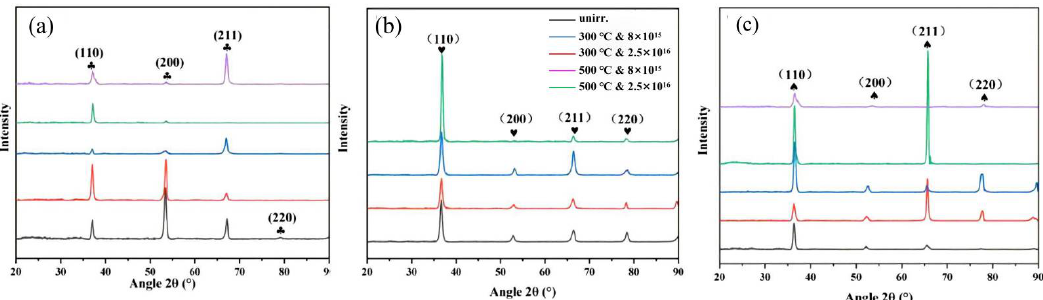
Figure 5. XRD patterns of the unirradiated and irradiated MEAs at different ion influences and tem- peratures. ( a ) Zr 40 Nb 35 Ti 25 (1#), ( b ) Zr 50 Nb 35 Ti 15 (2#), and ( c ) Zr 60 Nb 35 Ti 5 (3#).